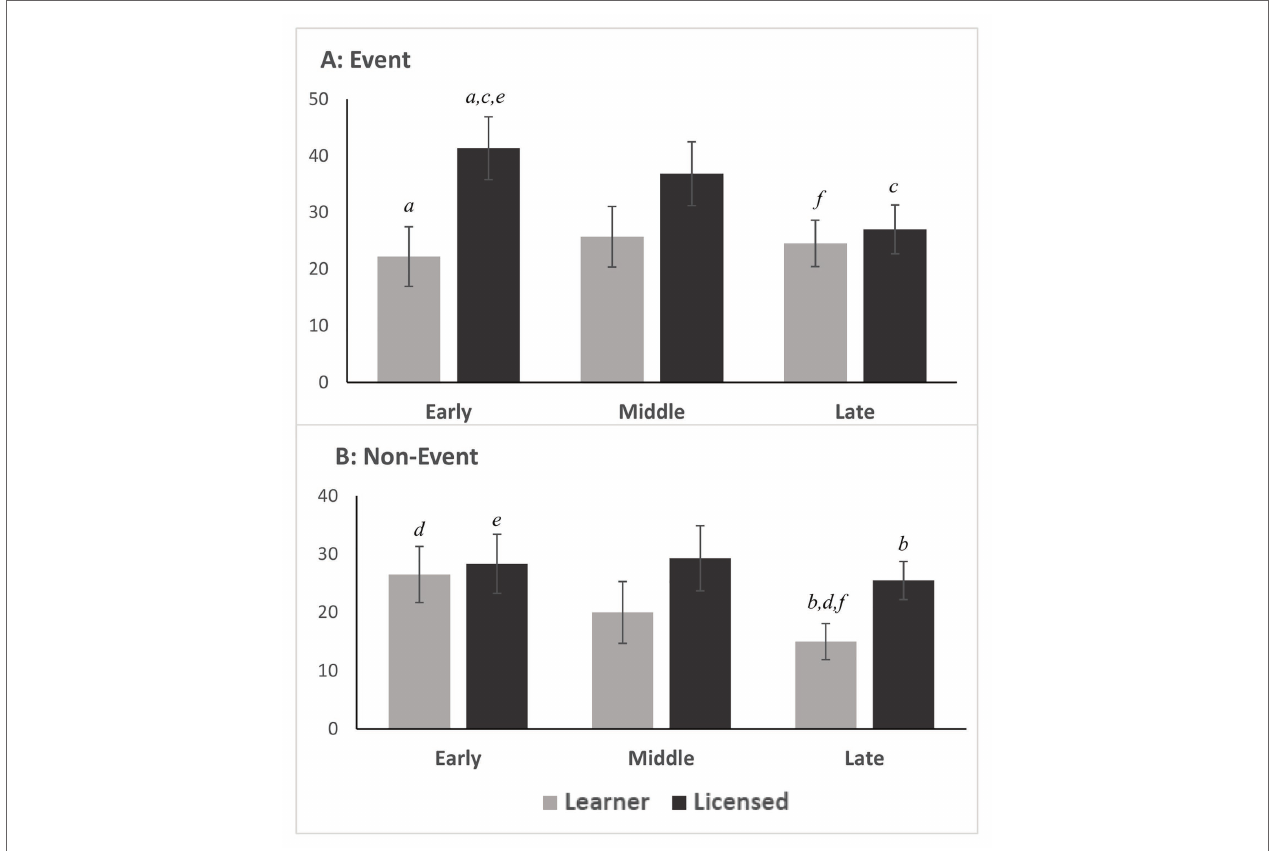
FIGURE 3 | Skin conductance response score by Onset Time and Group. SE bars. Matched letters indicate statistically significant differences in mean score. Panel (A) : in the Event videos, (a) Licensed drivers had a greater SCR score in the Early Onset compared to Learner drivers; (c) Licensed drivers had a greater SCR score in Early Onset compared to Late Onset . Panel (B) : in the Non-Event videos, (b) Licensed drivers had a greater SCR score in the Late Onset compared to Learner drivers; (d) Learner drivers had a greater SCR score in the Early Onset compared to Late Onset . Across Panels: (e) Licensed drivers had a greater SCR score in the Event Early Onset compared to Non-Event Early Onset ; (f) Learner drivers had a greater SCR score in the Event Late Onset compared to the Non-Event Late Onset